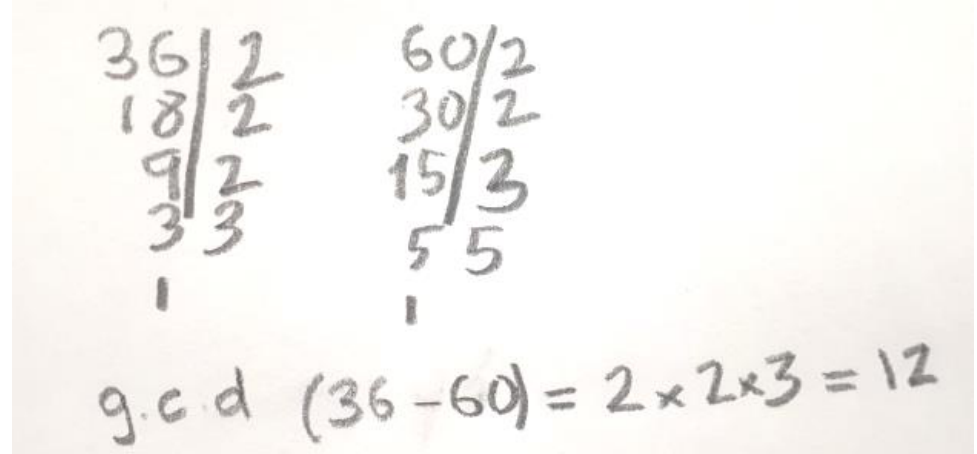
Figure 2. Example of answer with direct calculation g.c.d. for problem GCDDQ.